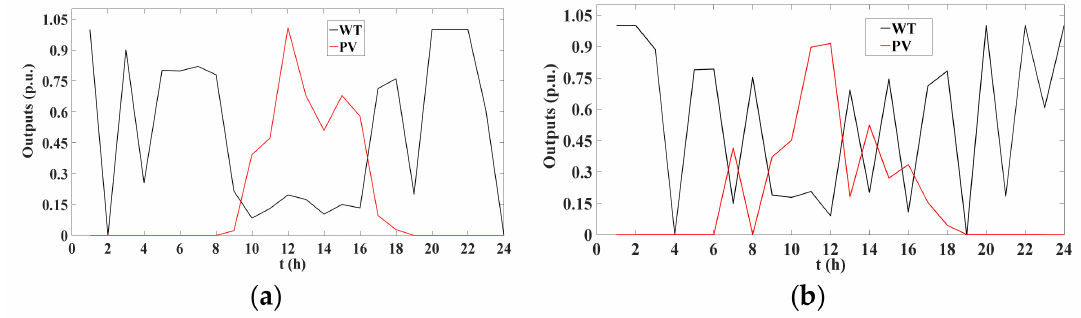
Figure 8. Samples of correlated PV and WT outputs with expected Spearman correlation coe ffi cients. ( a ) η = − 0.95. ( b ) η = − 0.65.